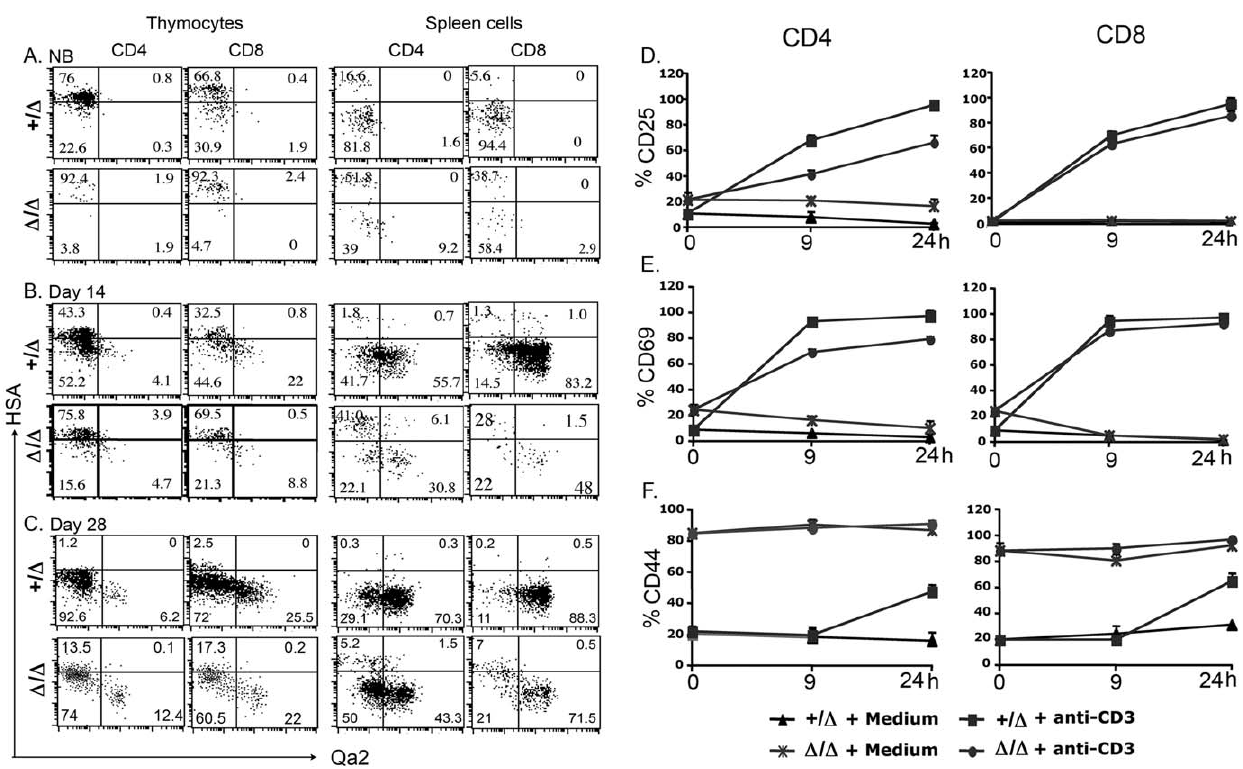
Figure 6. SP thymocytes and splenocytes show immature surface phenotypes and incomplete activation upon stimulation with anti-CD3. A, expression of HSA and Qa2 on thymocytes (left panel) and splenoytes (right panel) derived from NB, day 14 and day 28 Foxn1 + / D and Foxn1 D / D mice. D, E and F, expression of CD25, CD69, CD44 on peripheral CD4 (left) and CD8 (right) T cells after stimulation with anti-CD3 for 9 and 24 hours in vitro. The results shown were the average from two individual experiments.